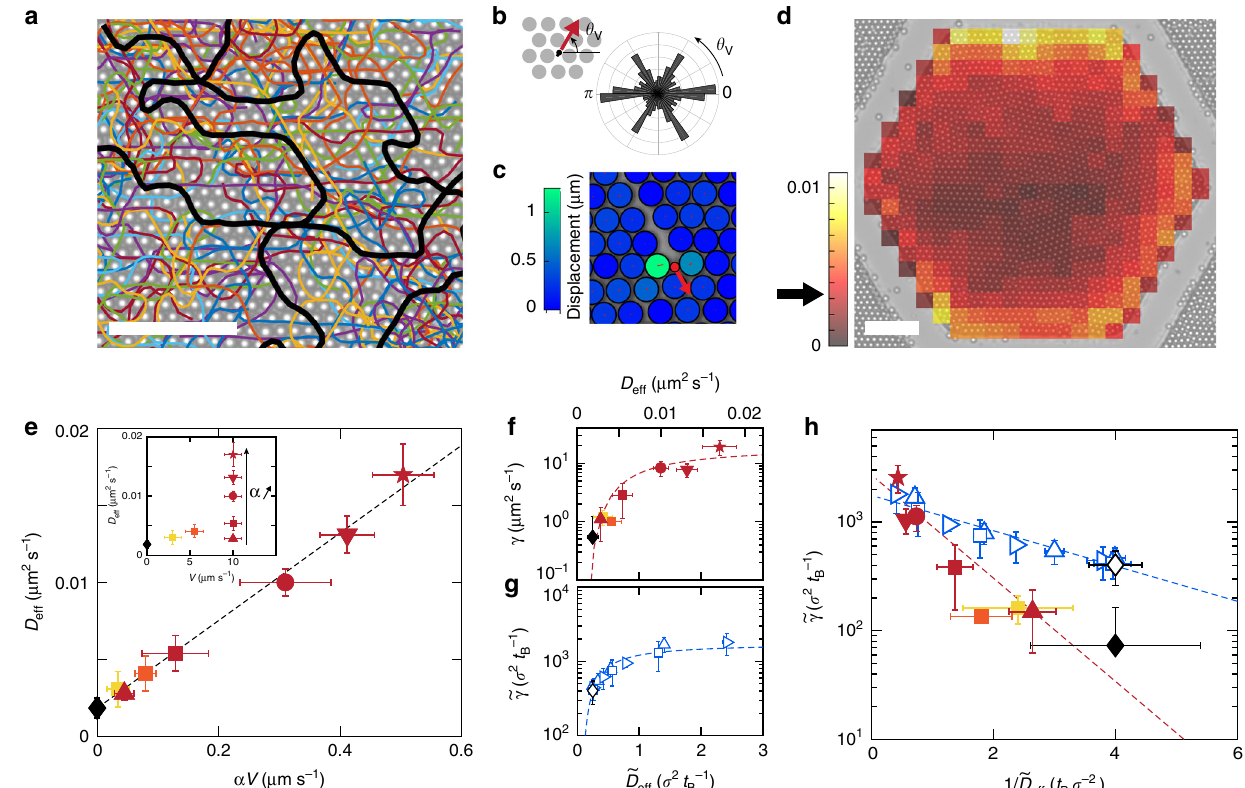
Fig. 2 Microscopic dynamics. a Individual trajectories of self-propelled particles in an ordered monolayer. Some trajectories are highlighted in black for better visibility. b The probability distribution of propulsion direction θ V of the active particles shows peaks along the natural directions of the crystal. c Displacement of colloids induced by a swimmer (red dot, the arrow indicates the direction of motion); the color-coding of particles denotes the amplitude of displacement (traced by red lines) following a collision. d Probability distribution of the presence of swimmers in the colloidal layer over the fi rst 20 min of an experiment. It is uniform (value for a uniform distribution indicated by an arrow), the swimmers do not localize on the walls, the grain boundaries or elsewhere. Scale bars, 50 μ m. e (inset) Measured diffusivity D eff of the passive colloids of the monolayer as a function of the speed V of the active particles. Colors distinguish speeds V = 3 (yellow), 5 (orange), 10 μ m s − 1 (dark red); and symbols refer to different fraction of swimmers α = 0.4 (upward